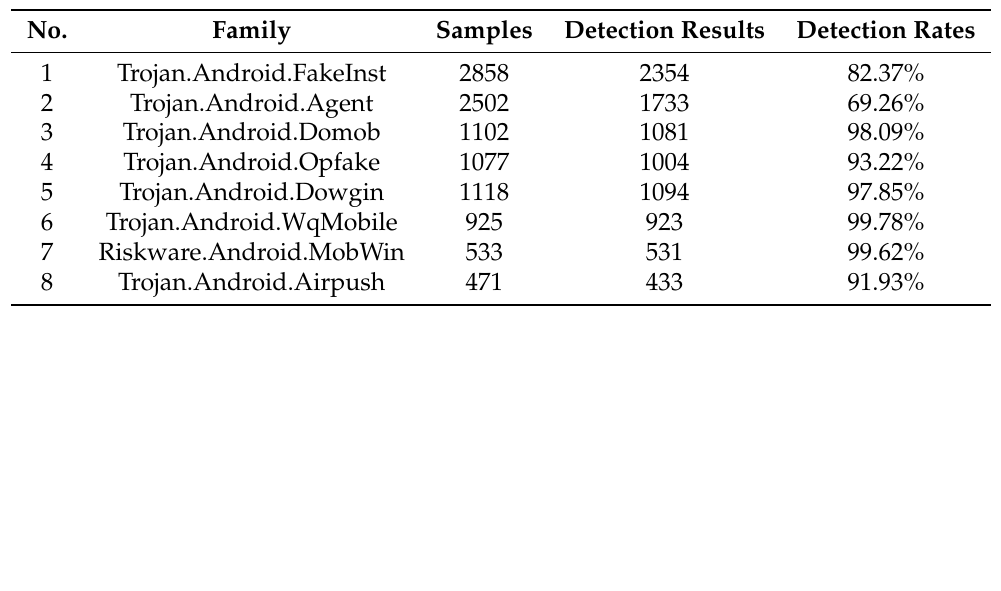
Table 12. Detection rates of the similar module